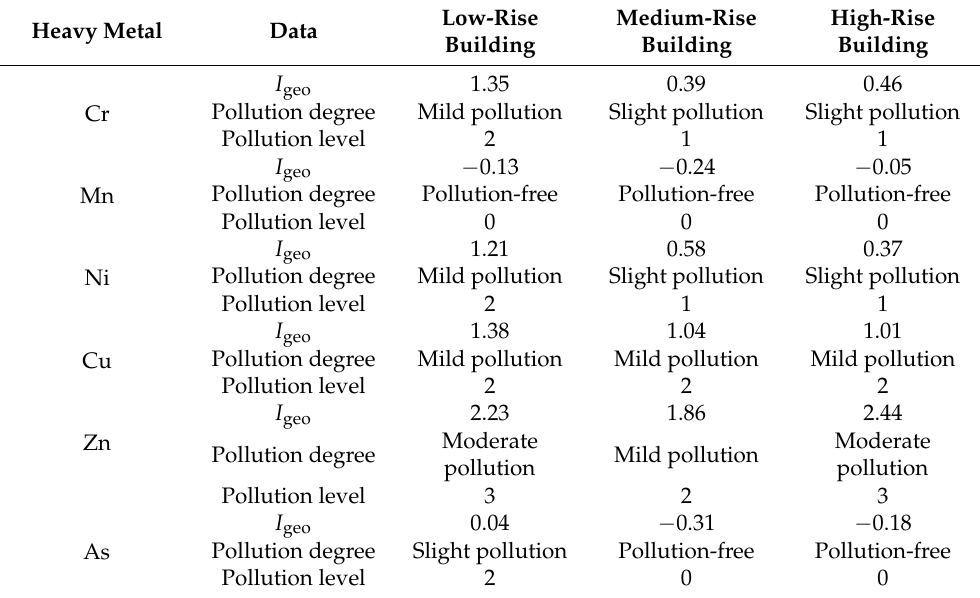
Table 5. Geoaccumulation indices for dust fall on buildings of different